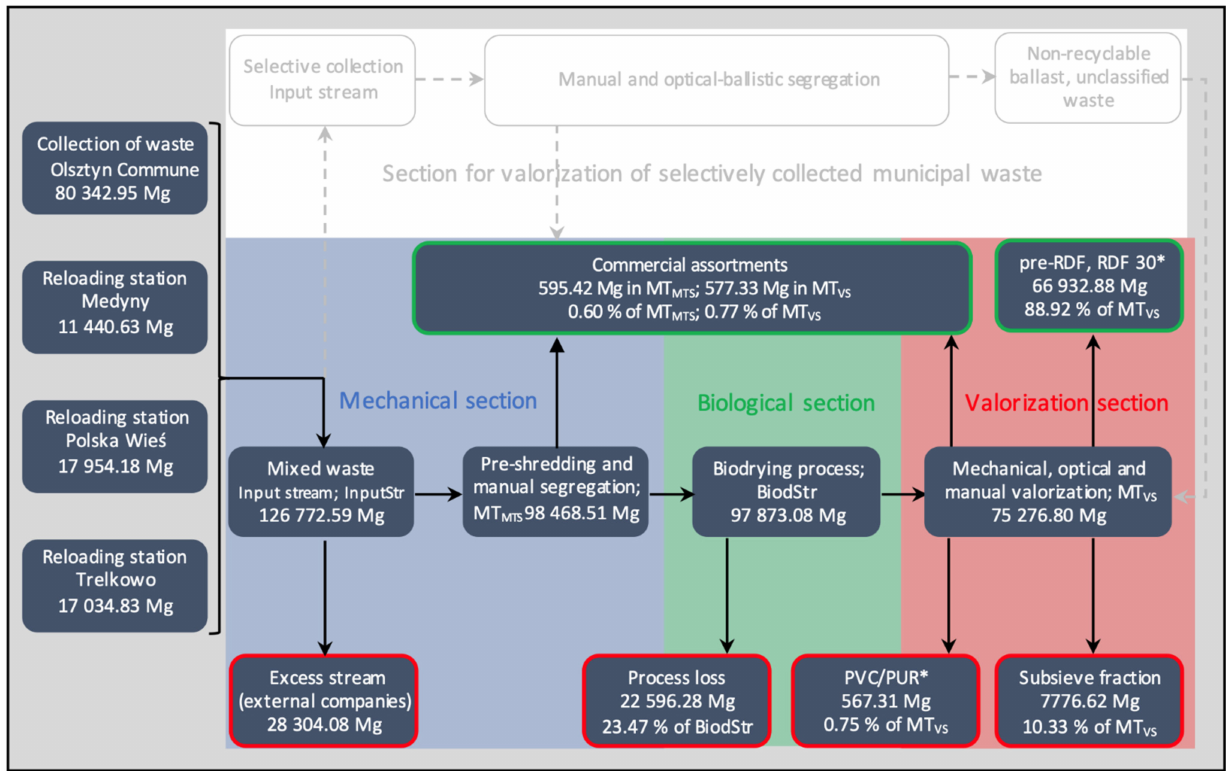
Figure 7. Average mass balance of the Municipal Waste Management Plant in Olsztyn for years 2016–2020 in the Mechanical- Biological Treatment Section; * RDF—Residual Derived Fuel, RDF 30—Residual Derived Fuel of <30 mm, PVC—Polyvinyl chlorine,